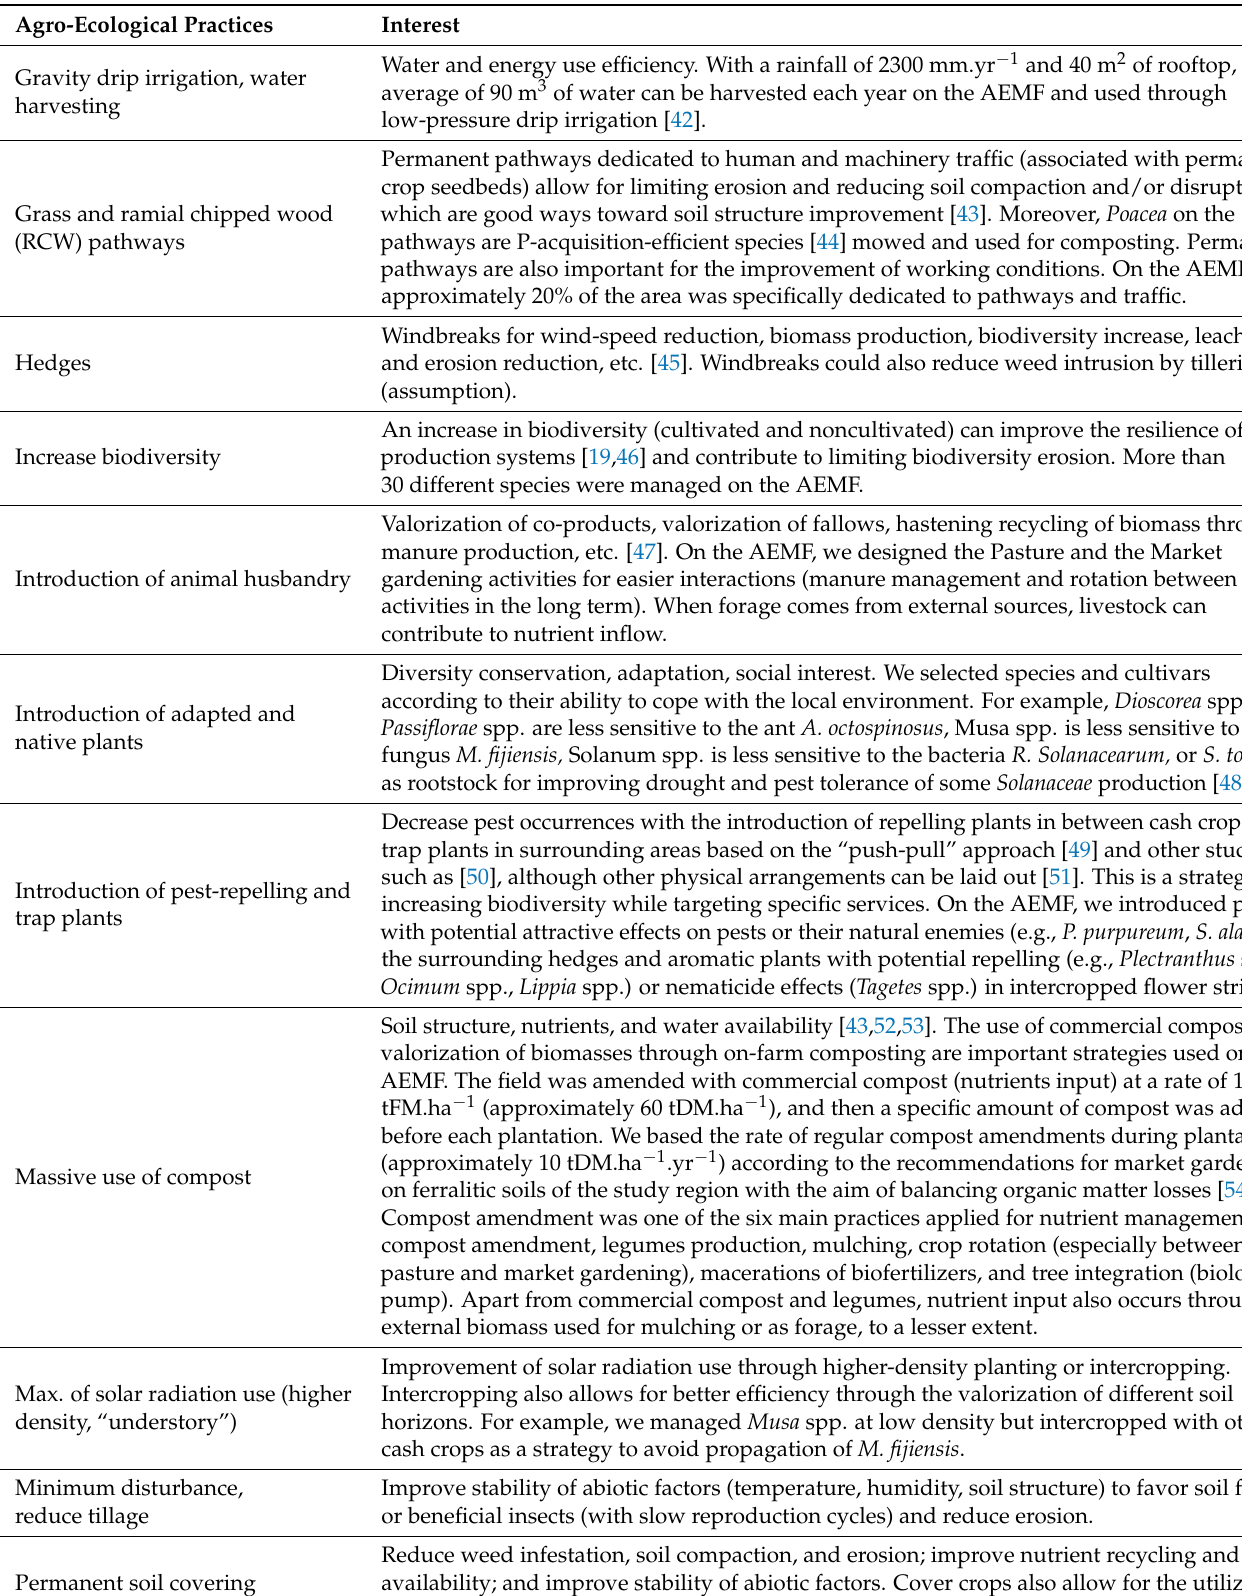
Table 1. List of agro-ecological practices defined during the co-design step and applied on the AEMF. Agro-Ecological